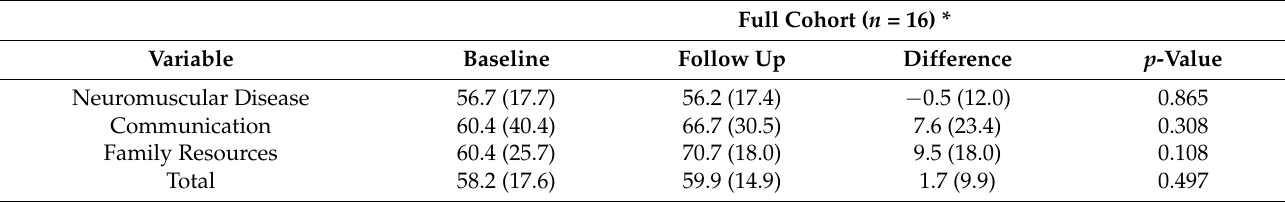
Table 2. Child Self-Repot PedsQL.